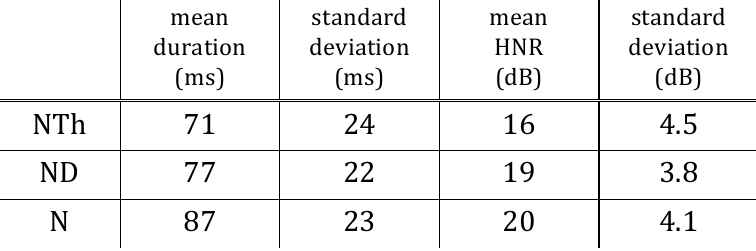
Table 4: Comparison of duration and HNR of nasals in different